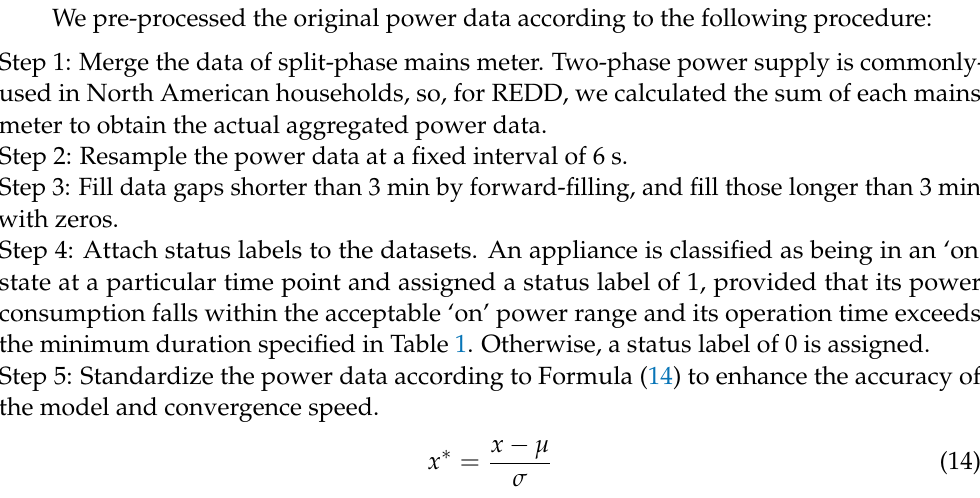
Table 1. Basic parameter settings of appliances.